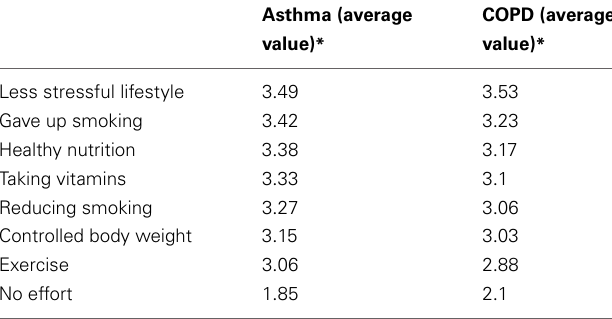
Table 4 | Efforts to maintain